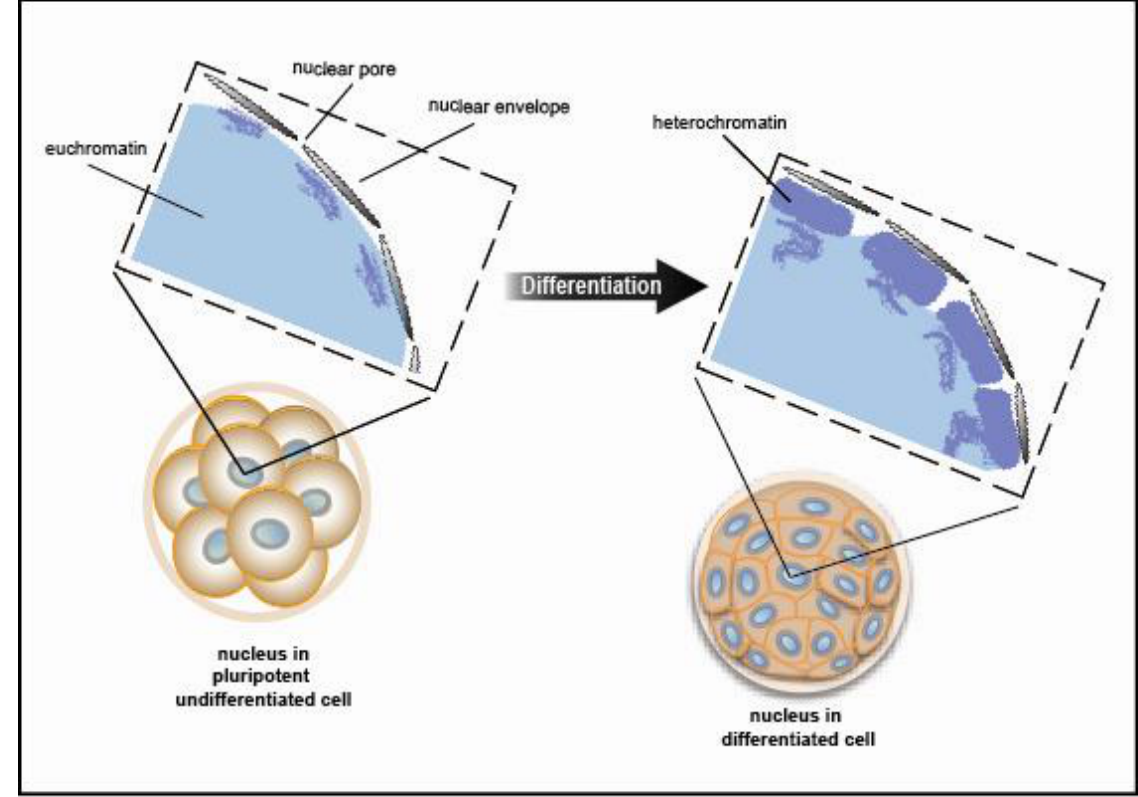
Figure 5. Changes in chromatin fiber density may distinguish pluripotent and differentiated cell types. Schematic view (interpreted from the experimental data in reference [29]) of nuclei from pluripotent cells (left) and differentiated cells (right) using electron spectroscopic imaging to visualize the chromatin organization. Undifferentiated cells have a less compact, more euchromatin (open chromatin structure) as compared with the heterochromatin (closed chromatin structure) present in differentiated